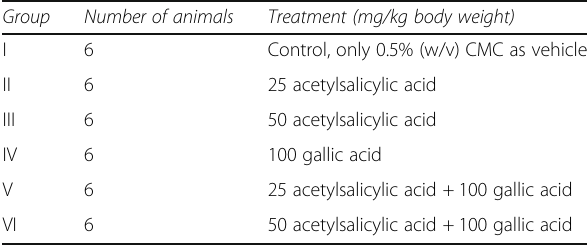
Table 1 Experimental design to determine the modulation of the specific activities of drug metabolizing enzymes and endogenous antioxidant enzymes, as well as the level of peroxidative damage